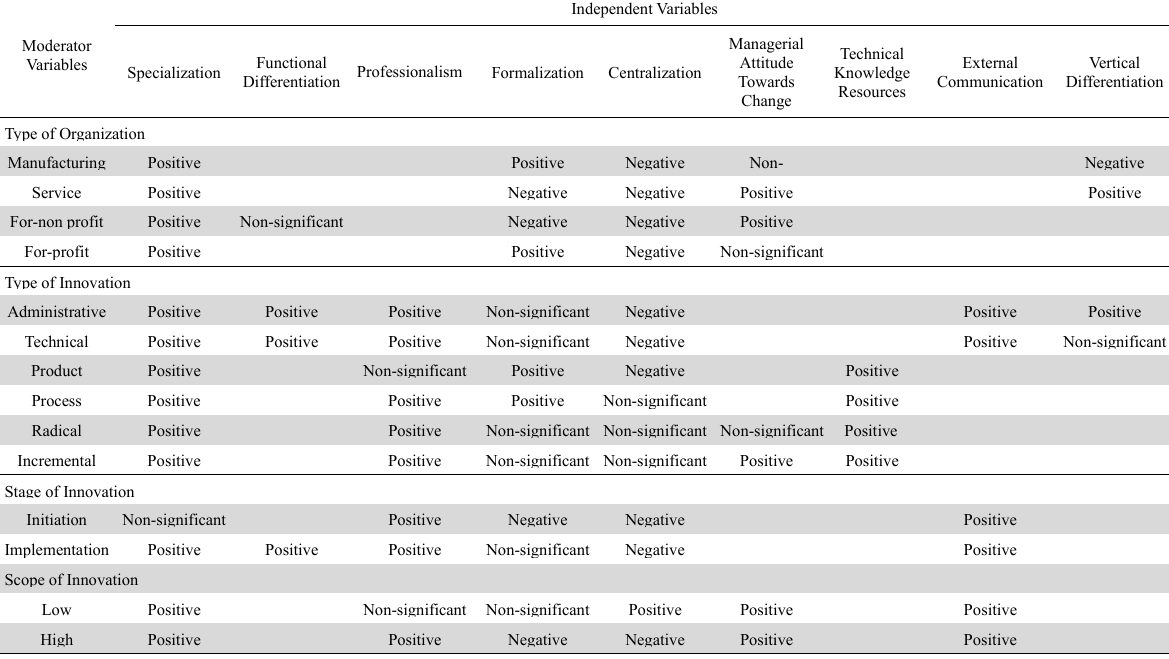
The influence of moderator variables on the relationship of independent variables and innovation (Source: Damanpour 1991)